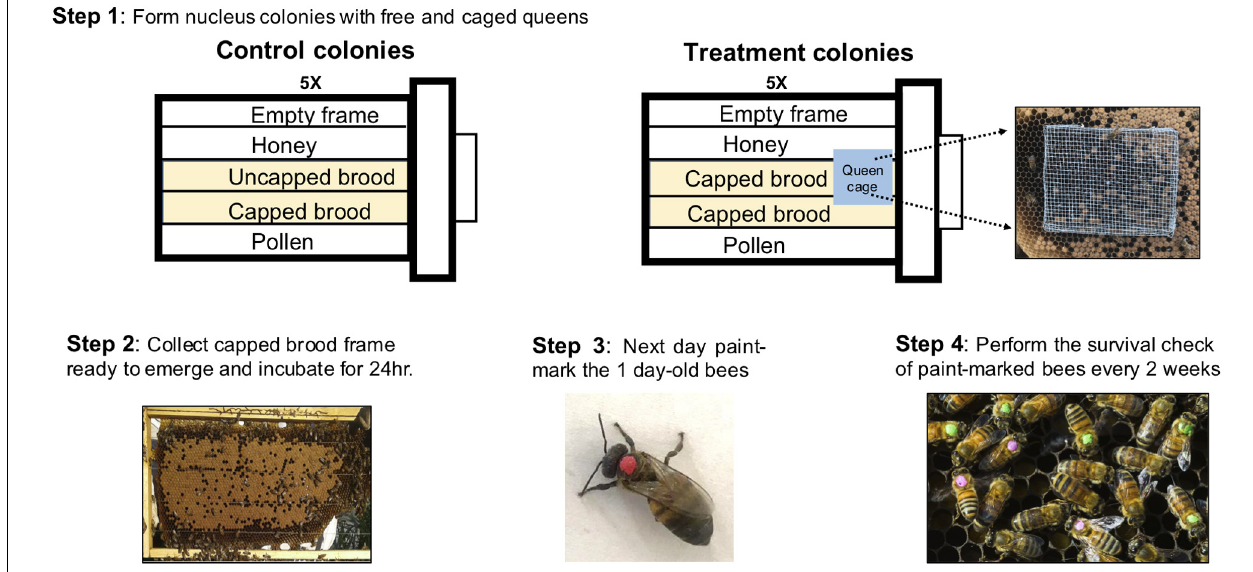
FIGURE 2 | Overview of the overall strategy, materials, and methods for worker life-span with reduced brood rearing. Control Colonies (CC) were set up to approximate the typical conditions of a colony in spring. Although no uncapped brood was present in Treatment Colonies (TC), overall amount of brood was equalized between the CC and TC by introducing capped brood from CC to TC as